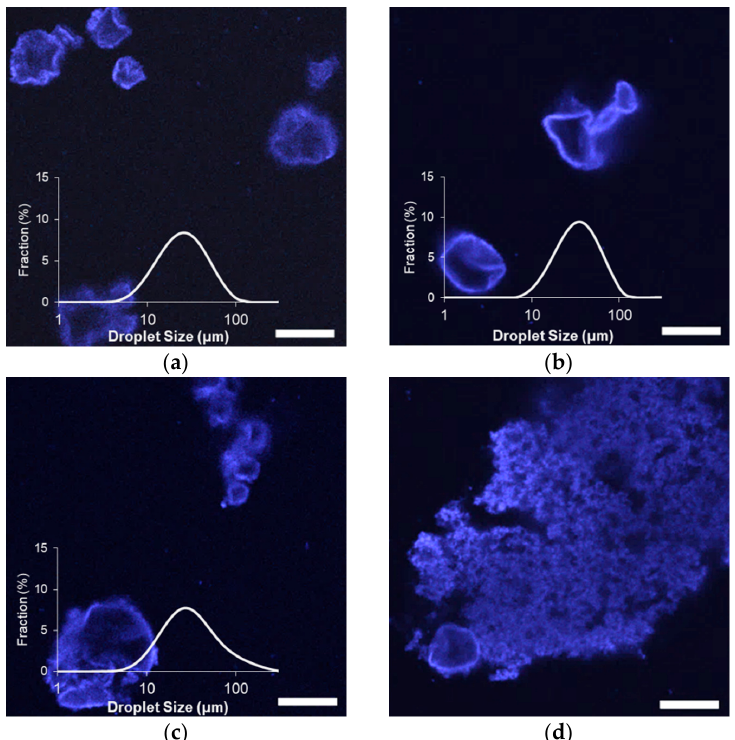
Figure 3. Effect of Blg microgel type on the droplet size distribution and morphology of limonene/corn oil-in-water emulsions after six weeks of storage: ( a ) MG 57 , ( b ) MG 58 , ( c ) MG 59 , ( d ) MG X ; scale bars = 20 μ m; droplet size distribution not shown in ( d ) because MG X emulsions contained large flocs visible to the eye and were not analyzed by light scattering. to the eye and were not analyzed by light